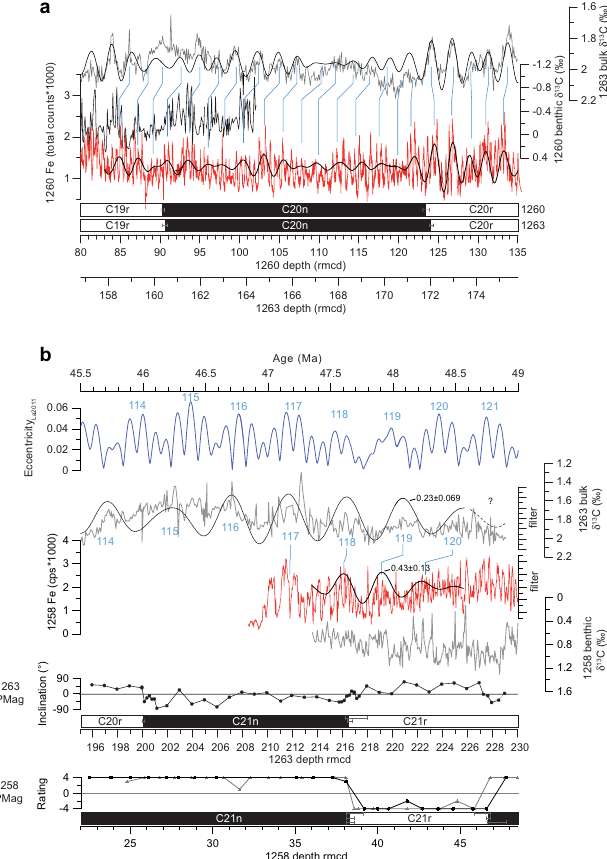
Figure 6. Connecting the 405kyr cyclostratigraphy of ODP Sites 1258 and 1260 with Site 1263. (a) Correlation of geochemical and paleomagnetic data from ODP Sites 1263 and 1260. Site 1260: ben- thic δ 13 C in black (25), XRF core scanning Fe intensities in red (5), magnetostratigraphy (Ogg and Bardot, 2001). Site 1263: bulk δ 13 C data in gray, magnetostratigraphy (both this study). For δ 13 C and Fe data also the 100kyr related cycle is filtered in the depth and age domain. Blue lines mark tie points between records. (b) Tying ODP Site 1258 with the astronomically calibrated Site 1263 record at the magnetochron C21n–C21r boundary. From top to bot- tom: La2011 eccentricity solution, bulk δ 13 C data and 100kyr filter from 1263 (this study), XRF core-scanning Fe intensities (Wester- hold and Röhl, 2009) and benthic δ 13 C data (Sexton et al., 2011) from 1258, inclination data and magnetostratigraphic interpretation of 1263 (this study), and polarity rating scheme and magnetostrati- graphic interpretation of 1258 (Suganuma and Ogg, 2006; Wester- hold and Röhl, 2009). The blue numbers denote the 405kyr cycle counted back in time from present day in La2011 and the respective 405kyr cycle in 1263. The small black numbers are the filter de- tails for 1263 δ 13 C and 1258 Fe. The correlation of cycle 118 and 119 over the magnetochron C21n–C21r boundary using δ 13 C data connects the cyclostratigraphy of the early Paleogene with the ATS of the Neogene and late Paleogene. This closes the mid-Eocene cy- clostratigraphic gap and concludes a fully calibrated ATS for the entire